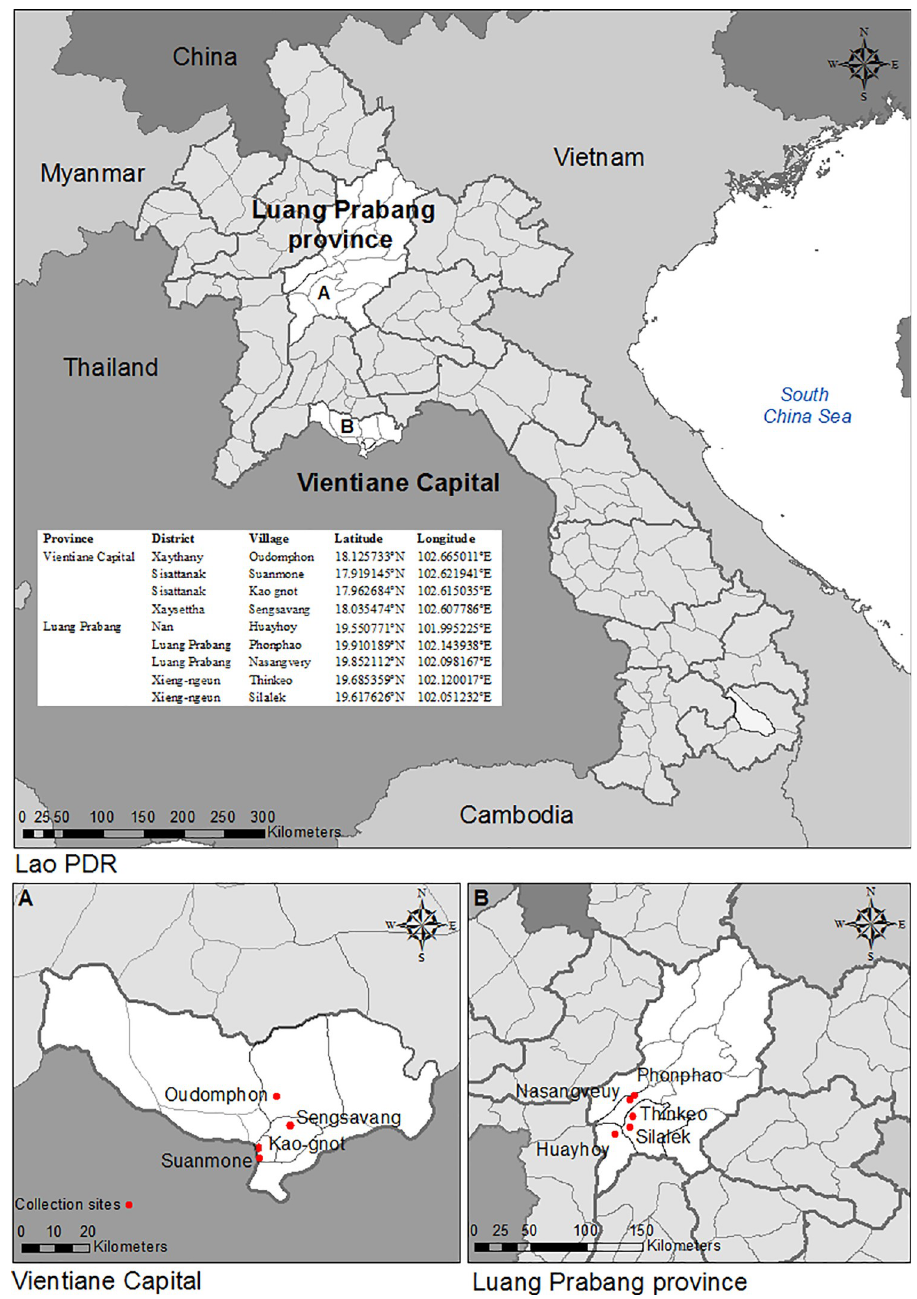
Fig 1. Map of Lao PDR showing the study sites in Vientiane capital and Luang Prabang provinces. rested on a bamboo bed covered by two untreated bed nets and collected mosquitoes from between the two nets for 10 minutes every hour. Mosquitoes were morphologically identified to species or species complex using the identification keys of Thailand [68]. Every month, in one study area 12 participants collected mosquitoes in the four different habitats simulta- neously for six hours, after which they were replaced by twelve new participants. This was repeated four times during several days to collect 48 h of monthly data in each habitat.